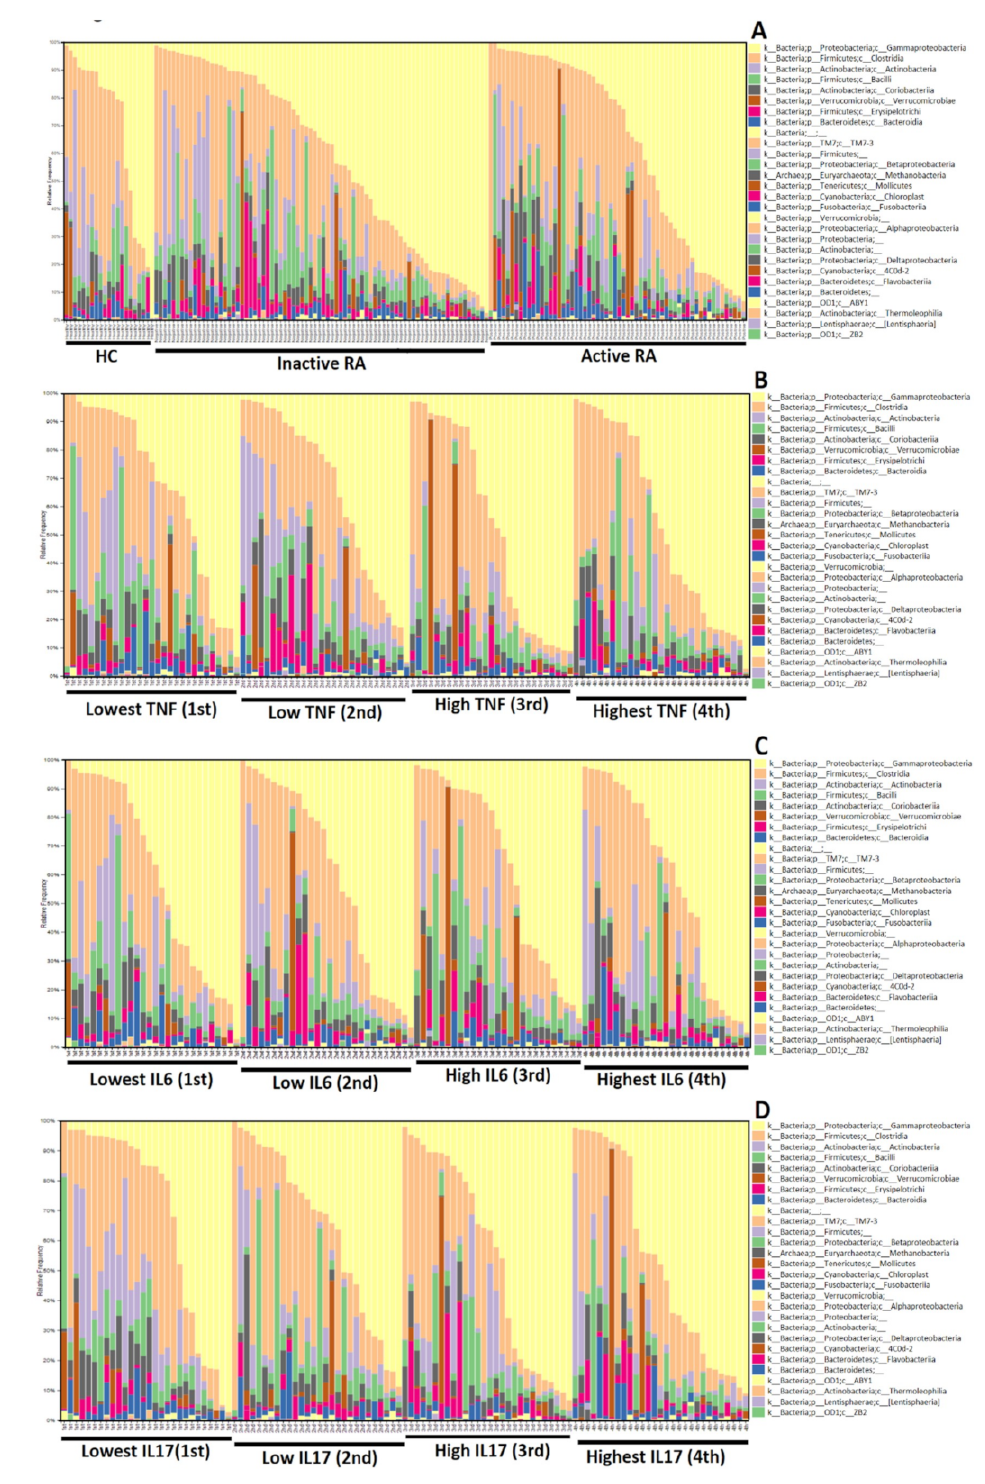
Figure 3. Gut microbial composition bar plots of the Greengenes class taxonomic levels from RA patients with di ff erent inflammatory cytokines and healthy controls (HC). Active RA was defined as the 28-joint disease activity score more than 3.2. TNF- α : tumor necrosis factor- α ; IL-6: interleukin-6; IL-17A: interleukin-17A. Cytokine levels were stratified into 4 groups by using the quantile